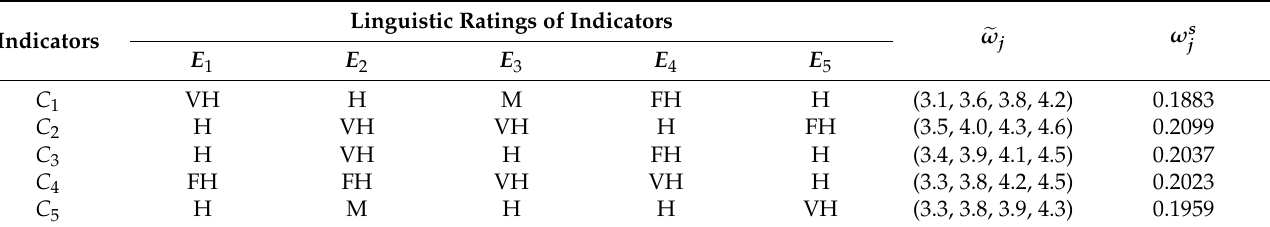
Table 5. Linguistic ratings and weights of